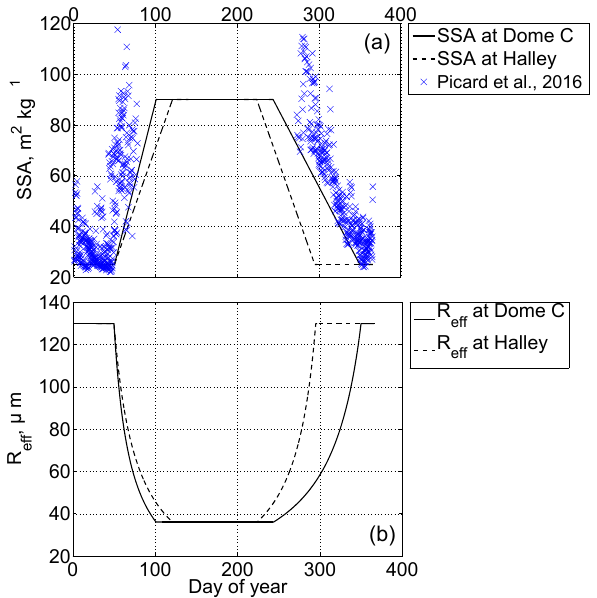
Figure B4. (a) Year-round estimates of the specific surface area (SSA) of snow at Dome C (solid line) and Halley (dashed line) were interpolated from observations at Dome C during 2012–2015 by Picard et al. (2016) ( × ). The SSA estimates for Halley take into account the shorter cold period compared to Dome C, which tends to have a larger SSA. (b) Year-round estimates of effective grain ra- dius ( R eff ) at Dome C (solid line) and Halley (dashed line) derived from Eq. (6).